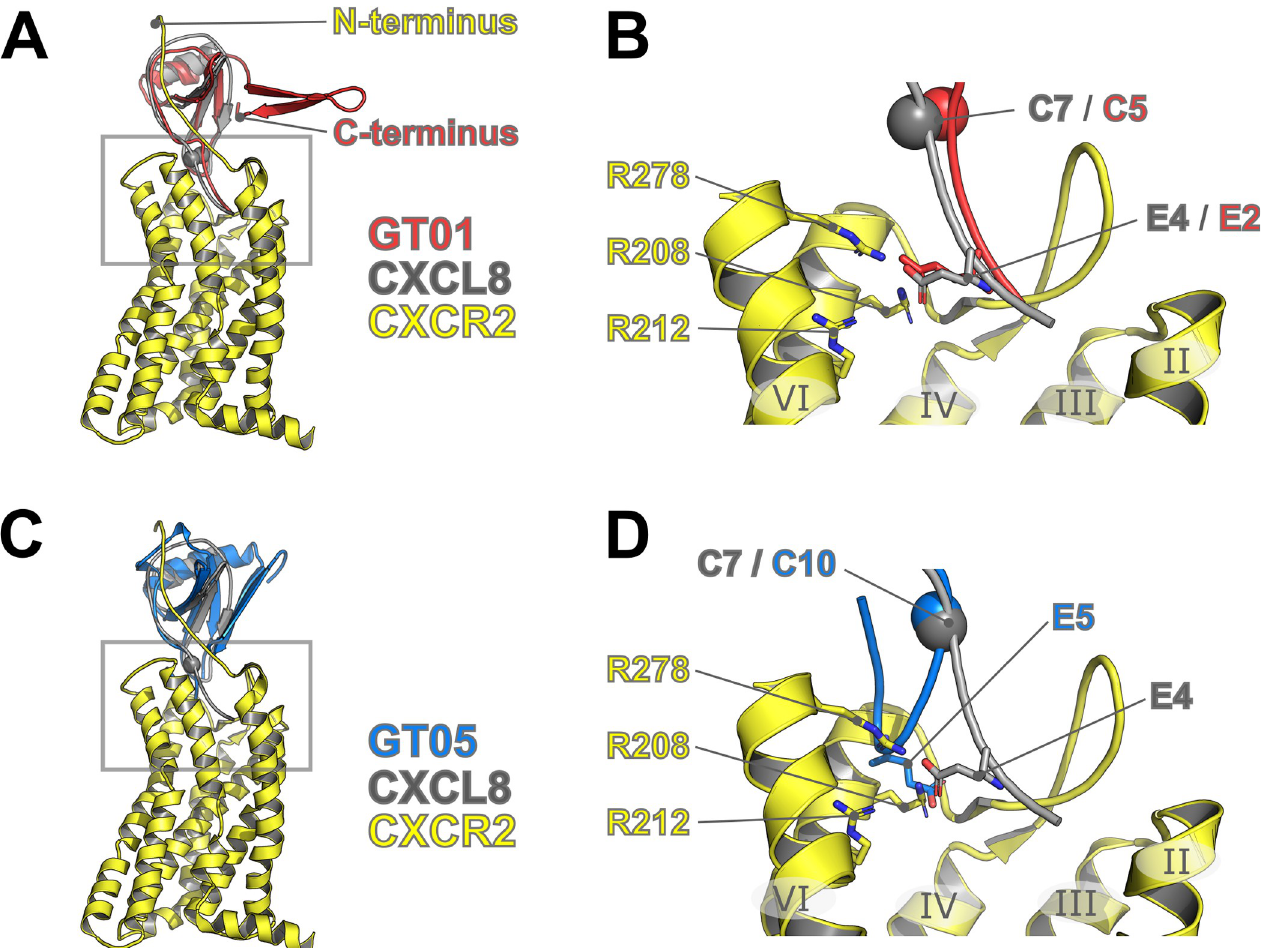
Fig 10. Alignment of vCXCL1 GT1 and vCXCL1 GT5 models with CXCL8 in the experimental CXCL8:CXCR2 complex. (A) The top model (lowest Rosetta total score) for vCXCL1 GT1 is shown in cartoon form (red) aligned to the structure of the CXCL8:CXCR2 complex (PDB: 6LFO). The extended C-terminus is unlikely to interfere with binding to CXCR2, as the N-terminus of CXCR2 (chemokine-recognition site 1) binds the opposite side of the chemokine. (B) Expanded view of the boxed region in panel A showing important residues as sticks and numbered by residues present in the structure. The first conserved cysteine residue is shown as a sphere. The glutamate in the ELR motif is in a very similar position for both vCXCL1 GT1 and CXCL8. This residue has been shown to be critical for the activation of CXCR2 and interacts with receptor residues R208, R212, and R278. (C) The top scoring model for vCXCL1 GT5 is shown in cartoon form (blue) aligned to the structure of the CXCL8:CXCR2 complex. The β -hairpin is not predicted to interrupt site-1 binding in this model. (D) Expanded view of the boxed region in panel C showing important residues as sticks and numbered by residues present in the structure. The first conserved cysteine residue is shown as a sphere. vCXCL1 GT5 does not contain an ELR motif, instead the five residues proceeding the cysteine are 5-EGNGR-9 (Glu5 shown in stick form). The longer N-terminus in vCXCL1 GT5 is an unstructured loop in this model, which was generated without the receptor present. In this position, it is unlikely that Glu5 will make sufficient contact with the displayed receptor residues. During a binding event, the chemokine N-terminus may adopt a stable conformation, facilitated by Arg9, whereby Glu5 could participate in receptor activation. Alternatively, Asn7 may form ELR-like contacts sufficient to activate the receptor.